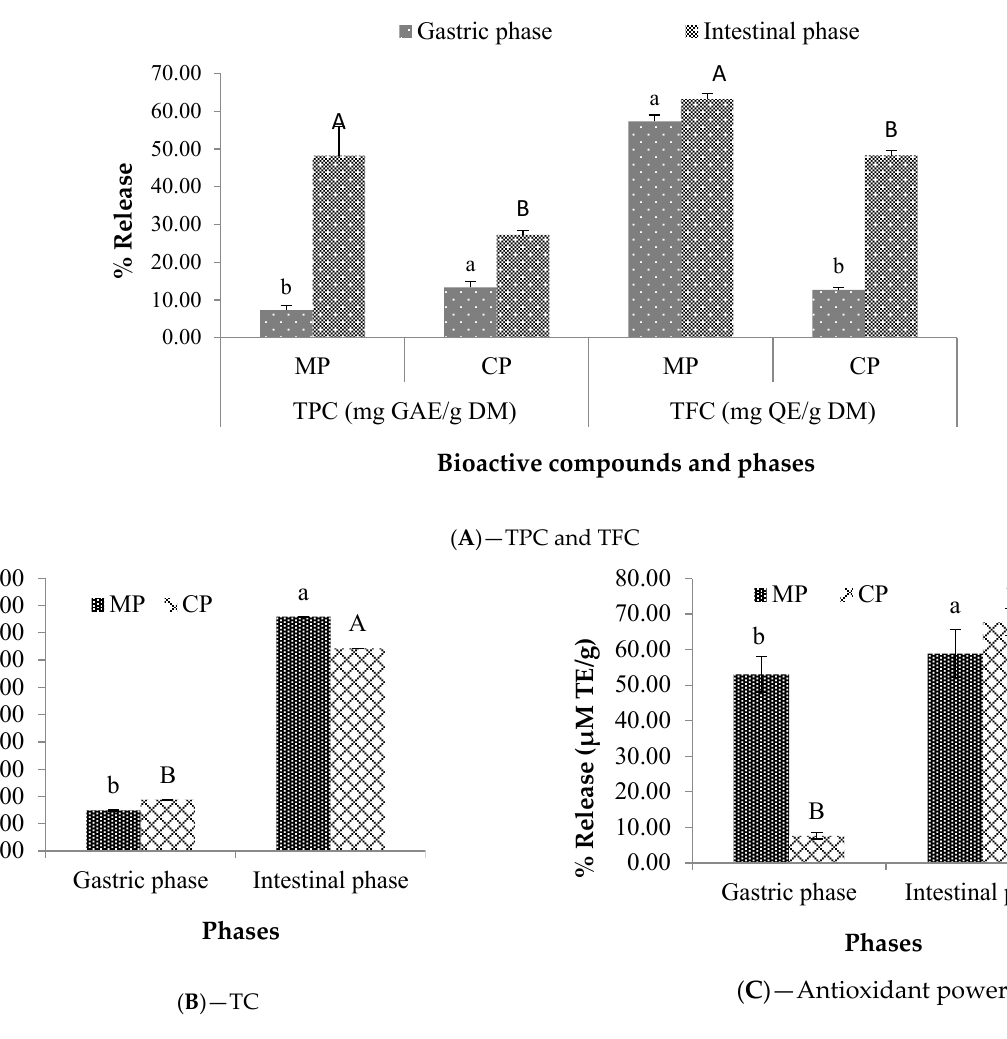
Figure 4. TPC, TFC ( A ), TC ( B ), and antioxidant activity ( C ) release (%) after 2 h of in vitro gastric and intestinal digestion of Ziziphus mauritiana crude and microencapsulated extracts. MP: Microencapsulated powder; CP: Crude powder; TPC: Total polyphenolic contents; TFC: Total flavonoid contents; TC: Total carotenoids. For each biocompound, the gastric phase averages that do not share any lower ‐ case letters are significantly different at the 0.05 threshold; the same applies to the averages of the intestinal phase that do not share any upper ‐ case letters.